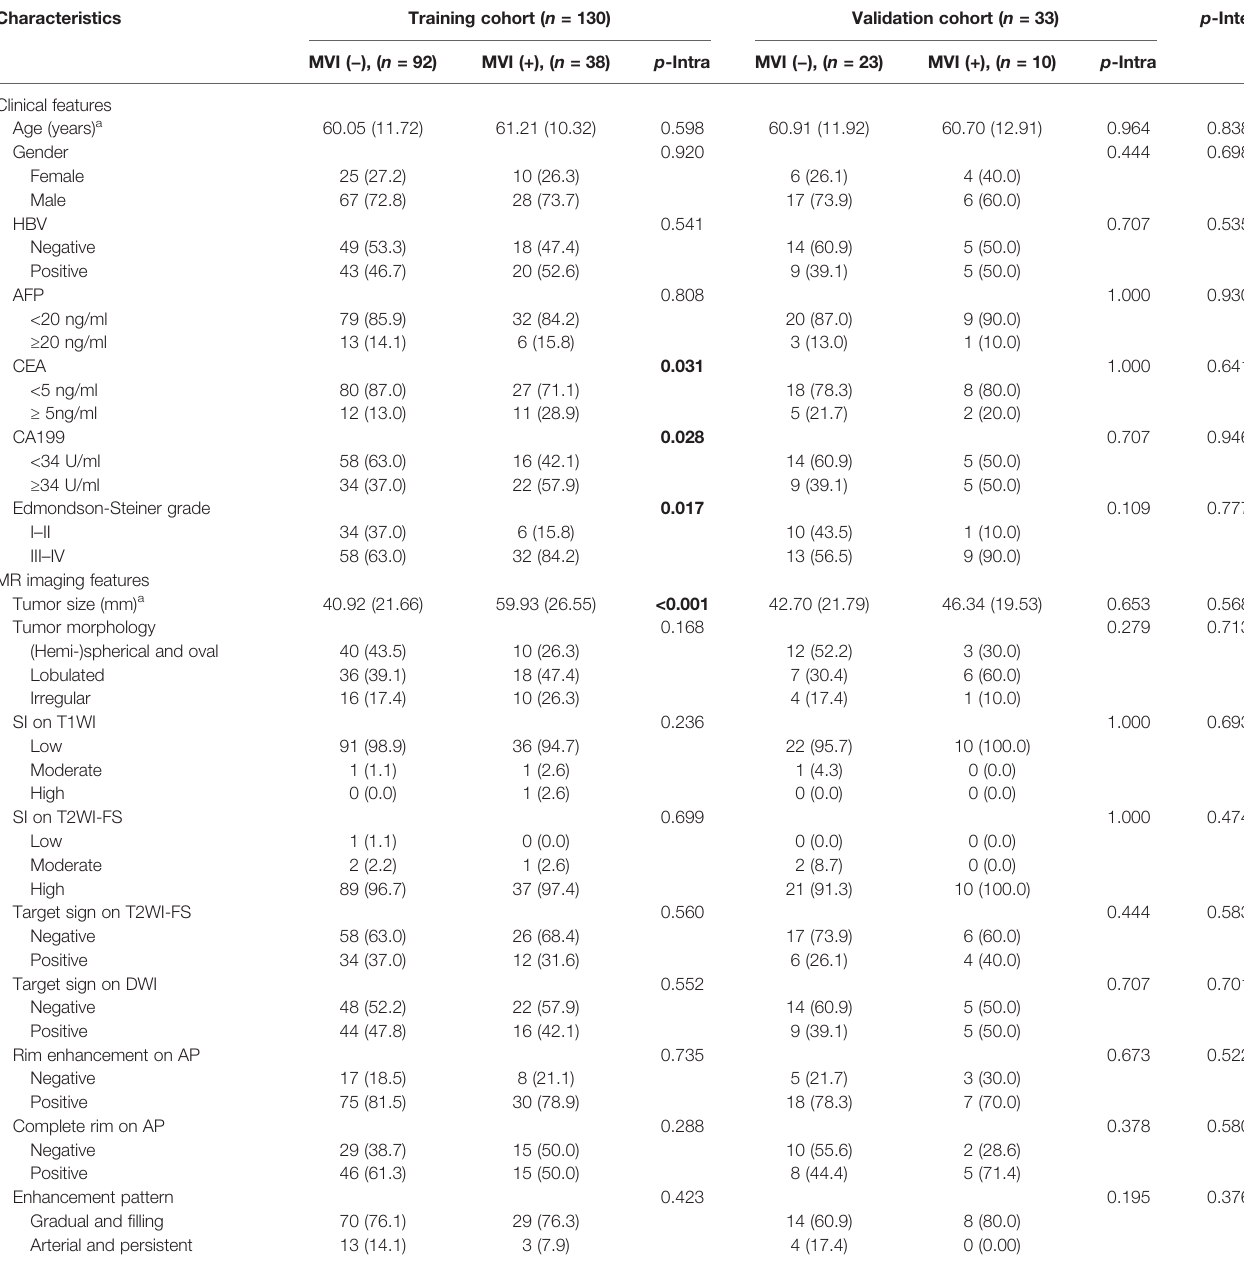
TABLE 1 | Comparison of MVI status and clinicoradiologic characteristics in ICC patients of training and validation cohorts.